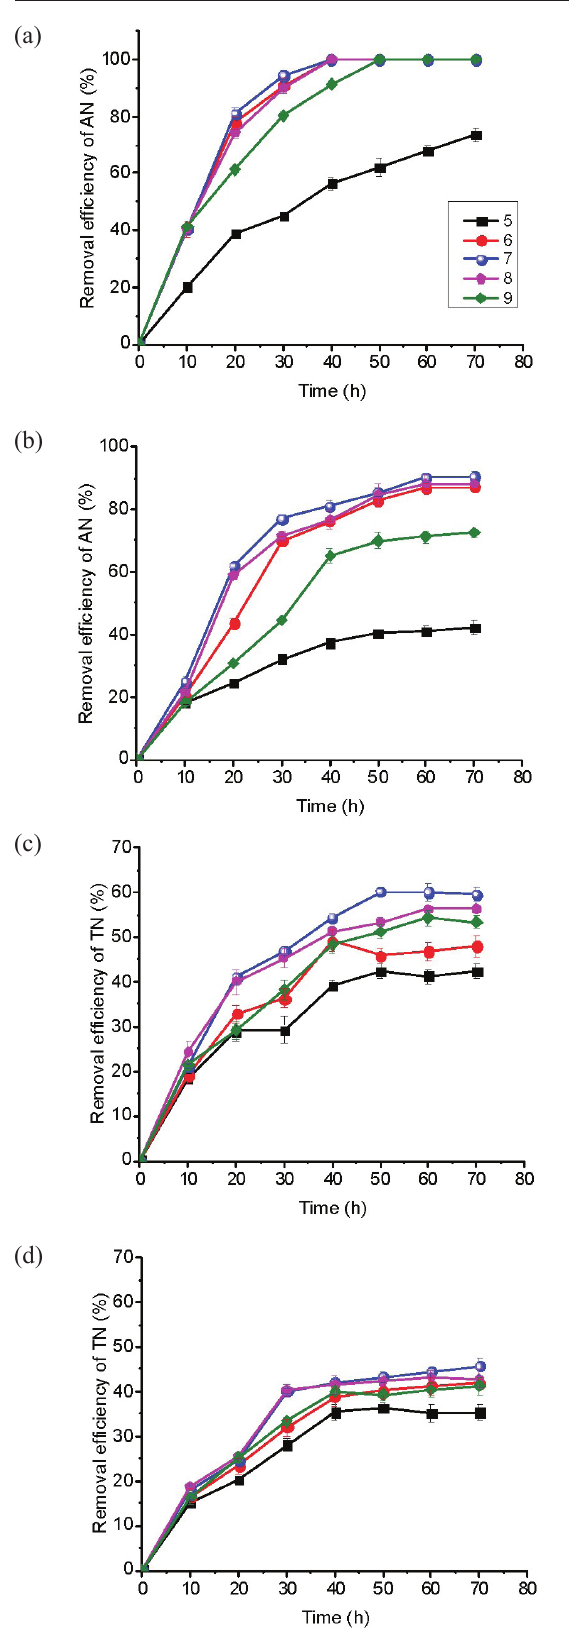
Fig. 7 – Effect of pH on AN removal by immobilized micro- organism (a) and free microorganism (b) and effect of pH on TN removal by immobilized microorganism (c) and free micro- organism